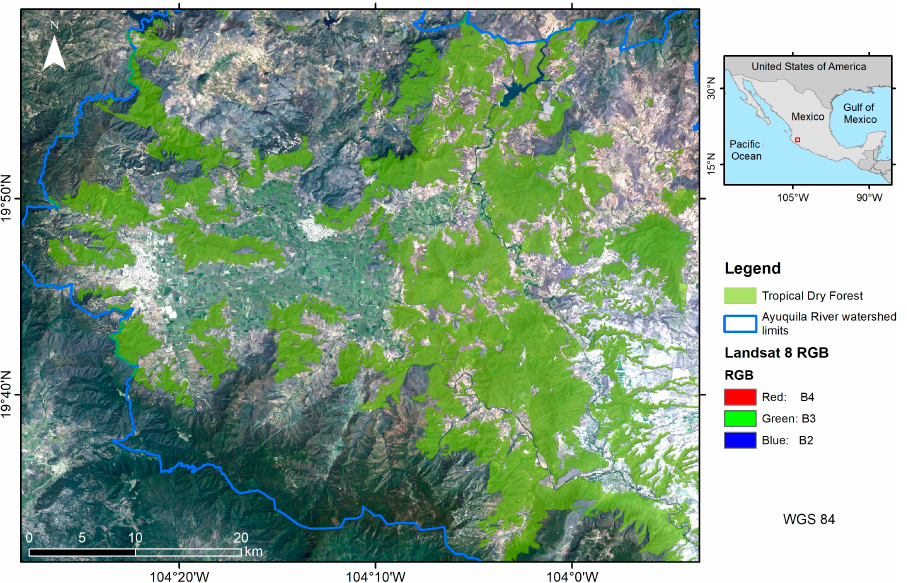
Figure 1. Location of the study area in the central west of Mexico. The background is a natural color composite of Landsat 8 imagery. The distribution of the tropical dry forest in the study area is shown in light green color.